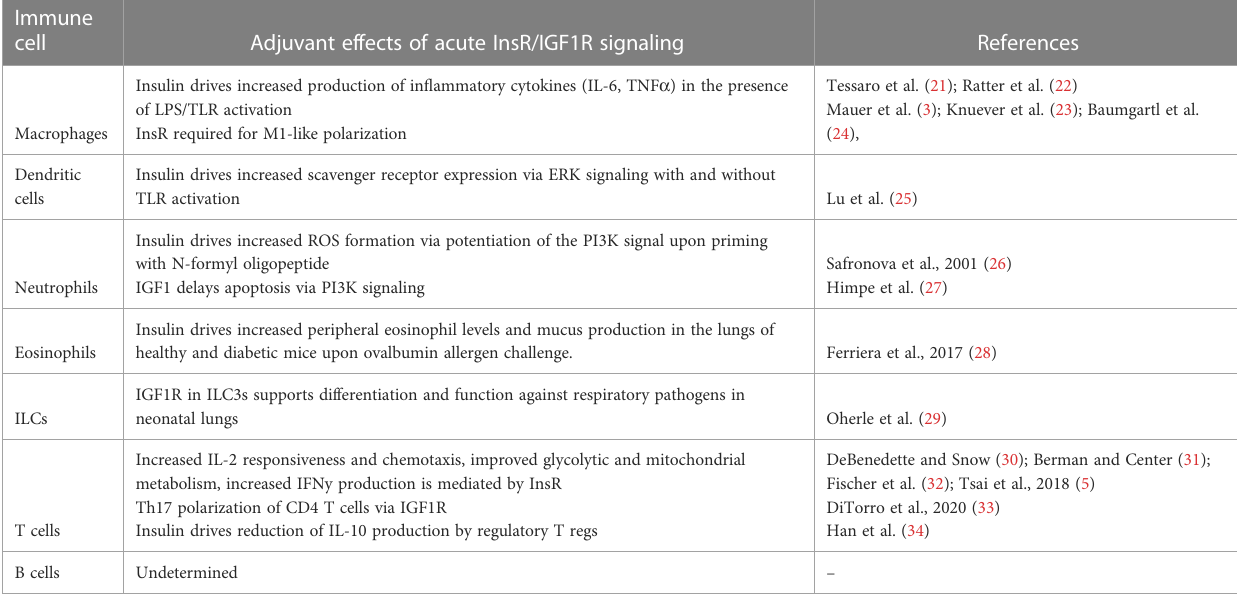
TABLE 1 The acute effects of insulin and IGF1R signaling on immune cells by cell type. Immune